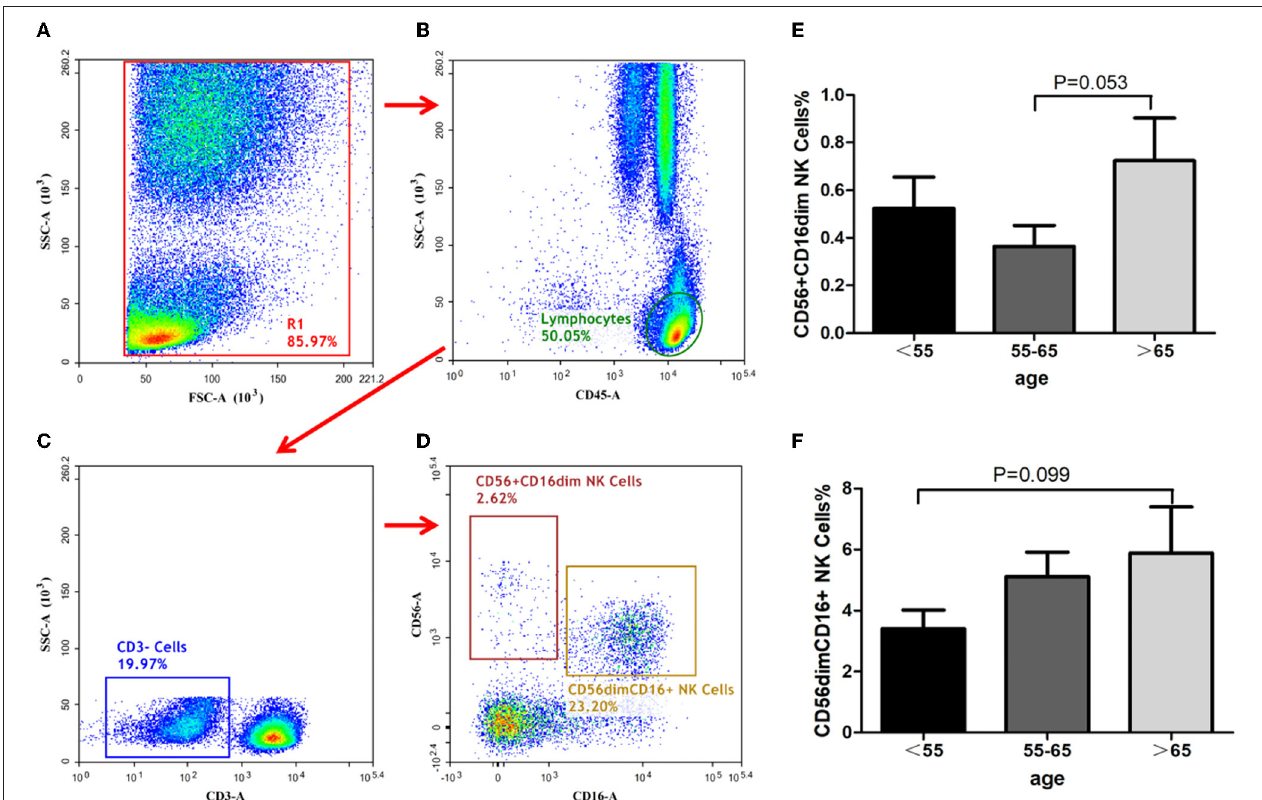
FIGURE 2 | Identification of NK-cells and analysis of its subsets. NK cells identification with the gating strategy. (A) : (R1). (B) : Lymphocytes. (C) : CD3 − cells. (D) : CD56 + CD16dim NK cells; CD56 dim CD16 + NK cells. Percentages of NK cell subsets among the 3 groups. (E) : CD56 + CD16dim NK cells. (F) : CD56 dim CD16 + NK